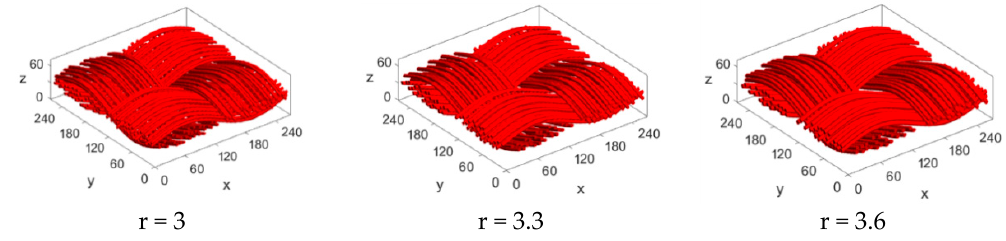
Figure 9. Carbon cloth models with different fiber radii (porosity = 0.81).